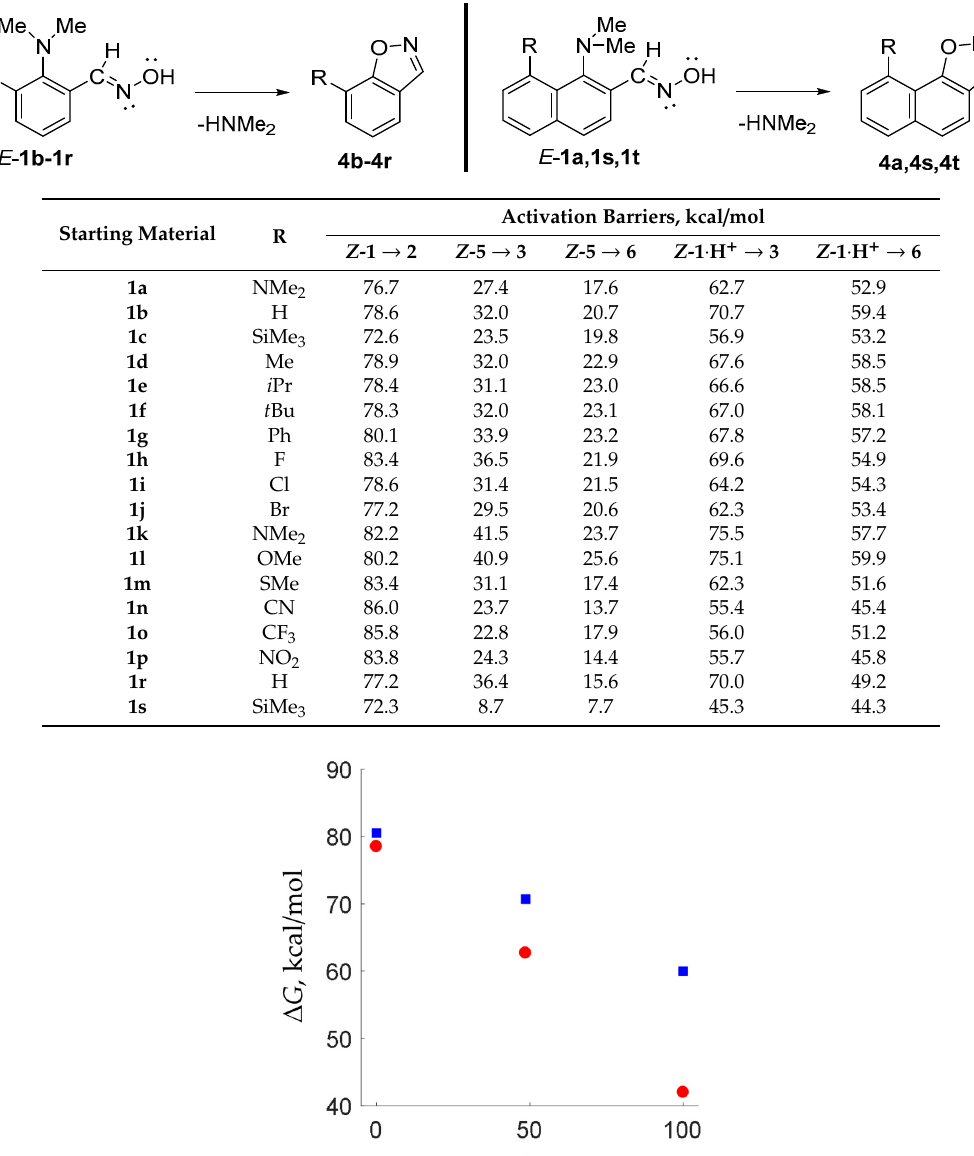
Table 1. Calculated activation barriers for the transformation of aldoximes 1a – 1s into isoxazoles 4a – 4s .